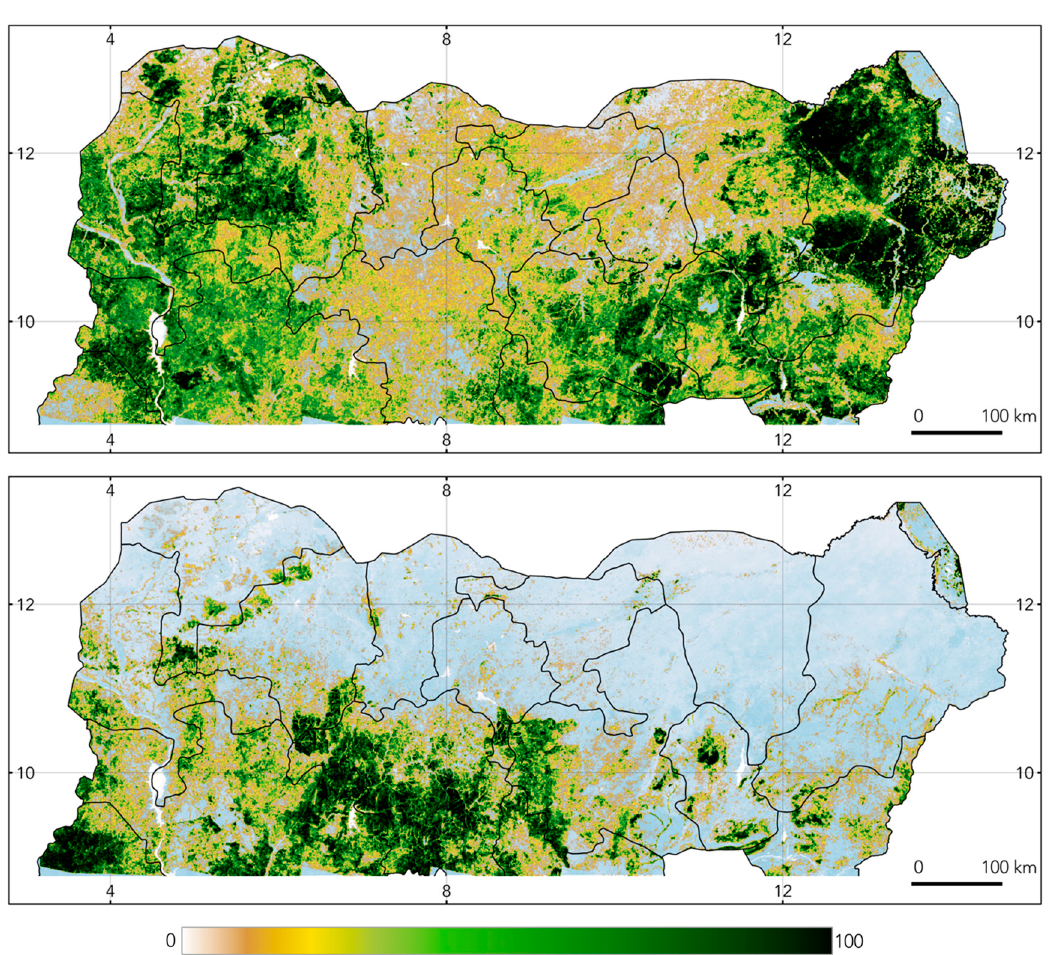
Figure 8. Northern Nigeria LCLU map 1 km spatial aggregation. Upper plate: distribution of temporary natural vegetation; Lower plate: distribution of permanent vegetation. Color bars represent percentage of natural vegetation.